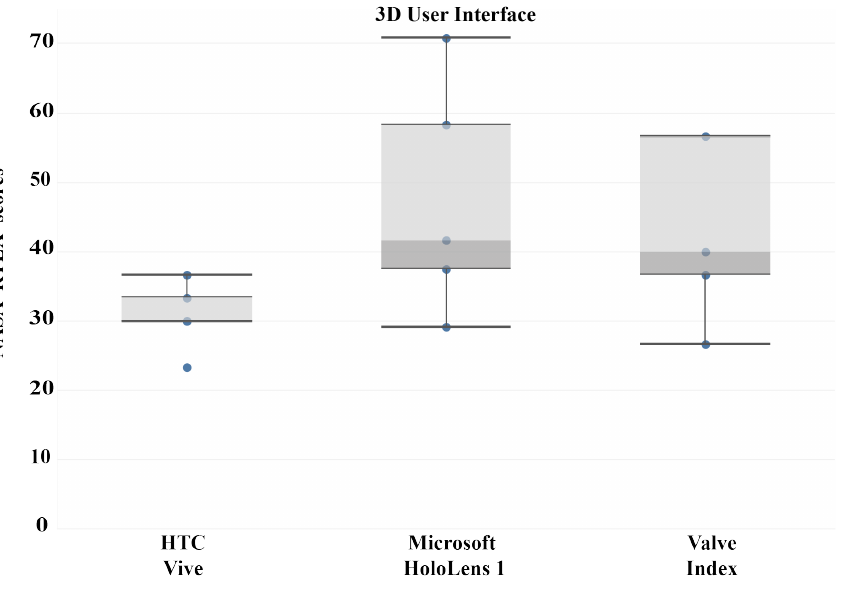
Figure 5. Task workload indices distribution using the NASA RTLX index for the HTC Vive, Valve Index, and Microsoft HoloLens 1 hand gesticulation. The box plot indicates the maximum and minimum values, first quartile (q1—darker grey), and third quartile (q3—lighter grey), data points (blue dots), outliers (blue points above and below the whiskers), and the median (i.e., the line between the dark and light gray boxes) within the interquartile